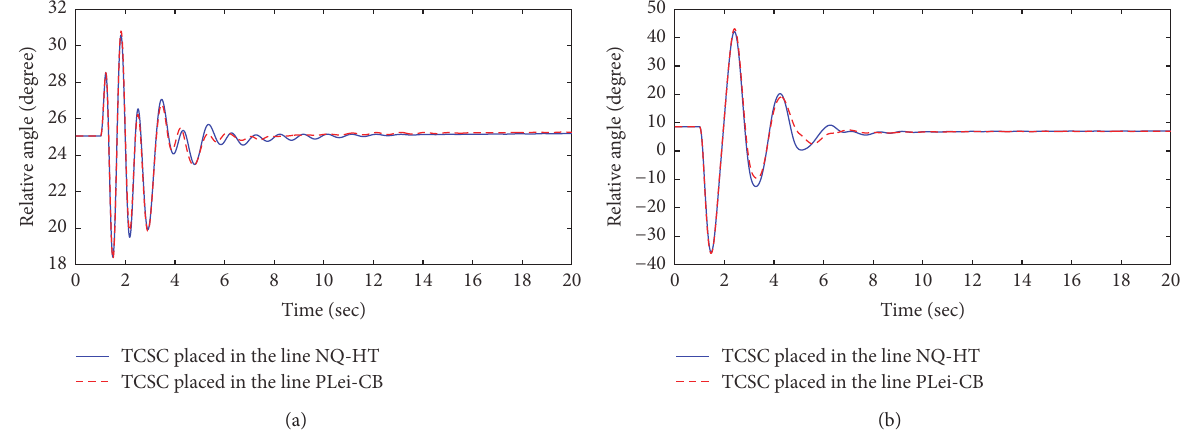
Figure 12: The relative angle oscillations of generator: (a) QuangNinh; (b) VinhTan.